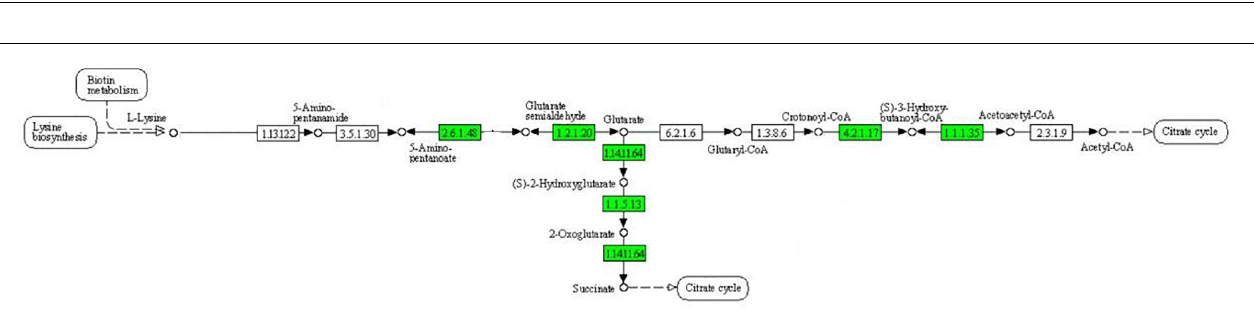
FIGURE 6 | Significantly enriched KEGG pathway: Lysine metabolism (from the KEGG database, green frames represent downregulation, and red frames represent upregulation).